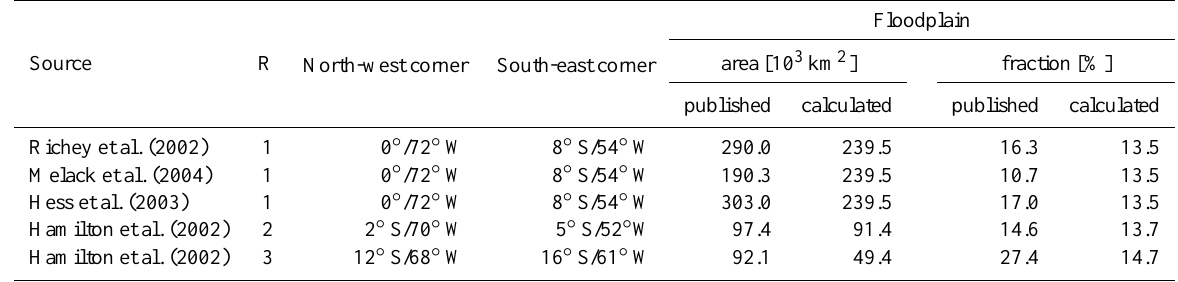
Table 6. Comparison of observed floodplain area and calculated floodable area in the subregions of the basin. R denotes the rectangle number in Fig.